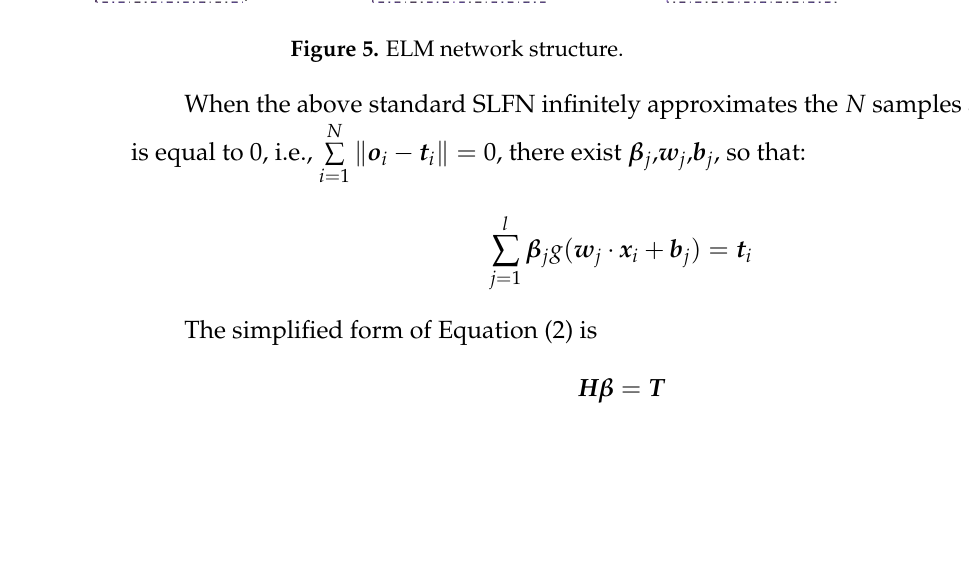
Figure 5. ELM network structure. When the above standard SLFN infinitely approximates the N samples and the error N ∑ is equal to 0, i.e.,